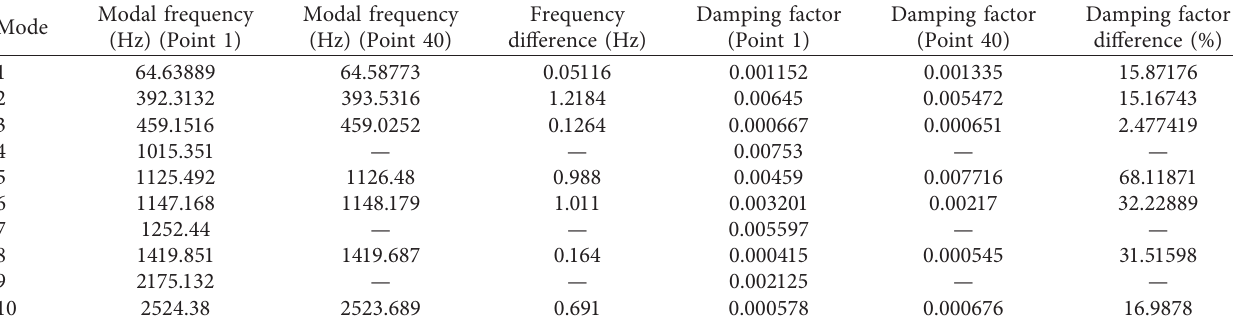
Table 4: The extracted modal